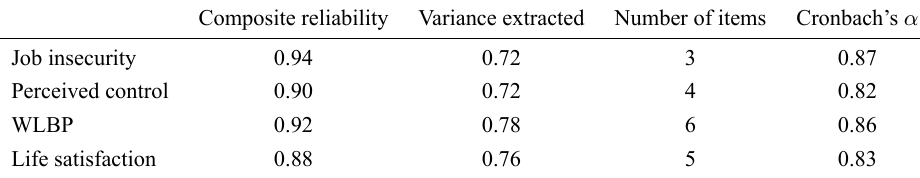
Table 2. Measurement properties.